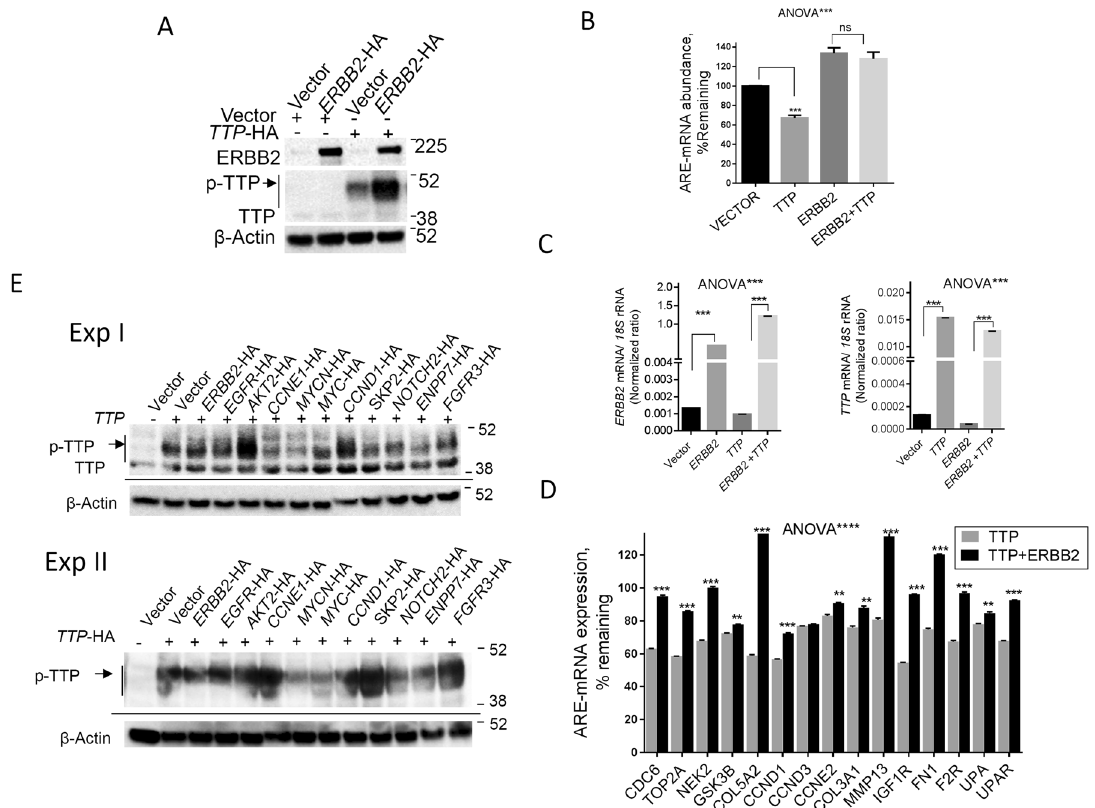
Fig. 7 Effects of ampli fi ed cancer genes on ZFP36/TTP phosphorylation. A HEK293 cells were co-transfected with ERBB2 -HA along with ZFP36/TTP -HA or vector control (0.5 µg each) for 24 h. Proteins were extracted, and immunoblotting was performed using antibodies to ERBB2, ZFP36/TTP, and β -actin. A representative blot from three experiments is shown. B Total RNA samples were extracted and subjected to RT-QPCR using speci fi c primers to the ERBB2-regulated ARE-mRNA s (as in Fig. 2D, E). Data are Mean ± SEM of average 18SRNA normalized expression of ARE-mRNA abundance remaining from vector control. C , D RT-QPCR using speci fi c primers to the indicated genes RT-QPCR using speci fi c primers to the indicated genes. Data in B to D are Mean ± SEM from an experiment with triplicate reactions of two independent experiments. Two-way ANOVA with Tukey ’ s multiple tests between the control and treatment test as indicated were used. *** p < 0.001. E Immunoblot analysis for ZFP36/TTP protein in HEK293 cells over-expressing cancer-ampli fi ed genes. HEK293 cells were co-transfected with cancer ampli fi ed genes and ZFP36/TTP -HA or vector control (0.5 µg each) for 24 h. The results of the two experiments are